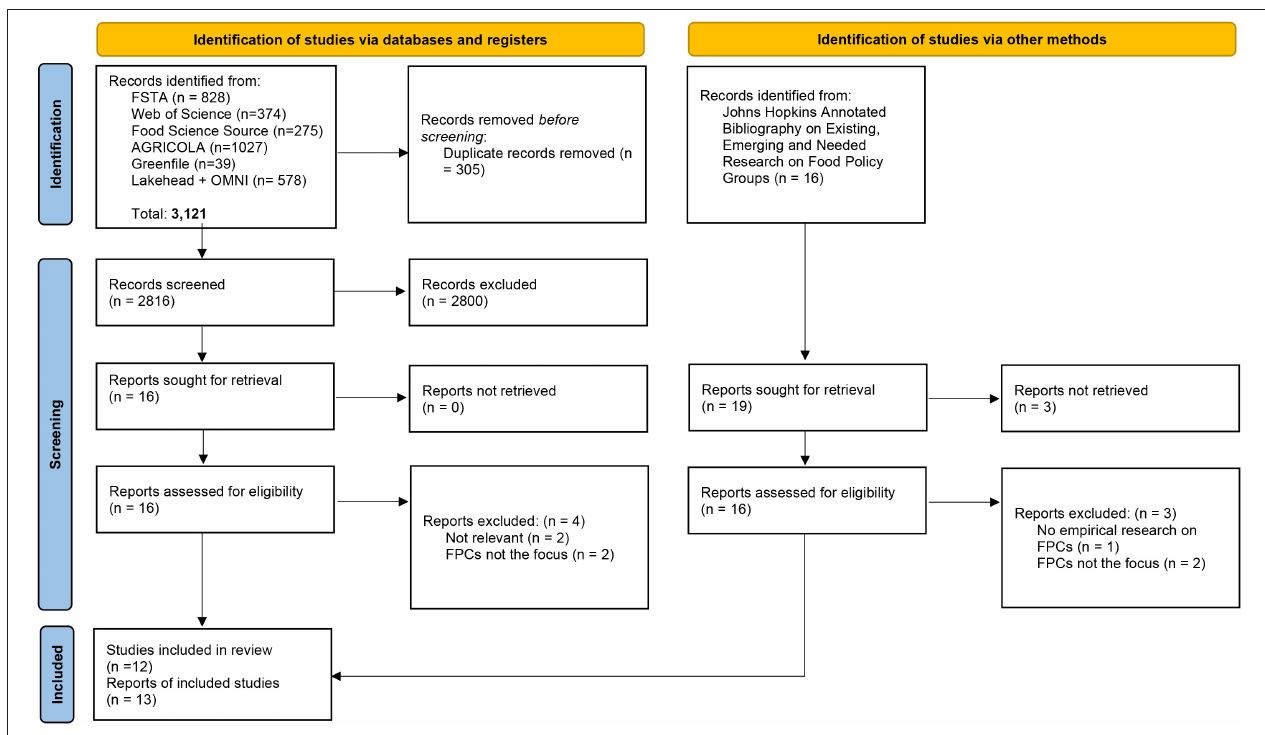
FIGURE 1 | Details of scoping review and citation selection process. Adapted from: Page et al.